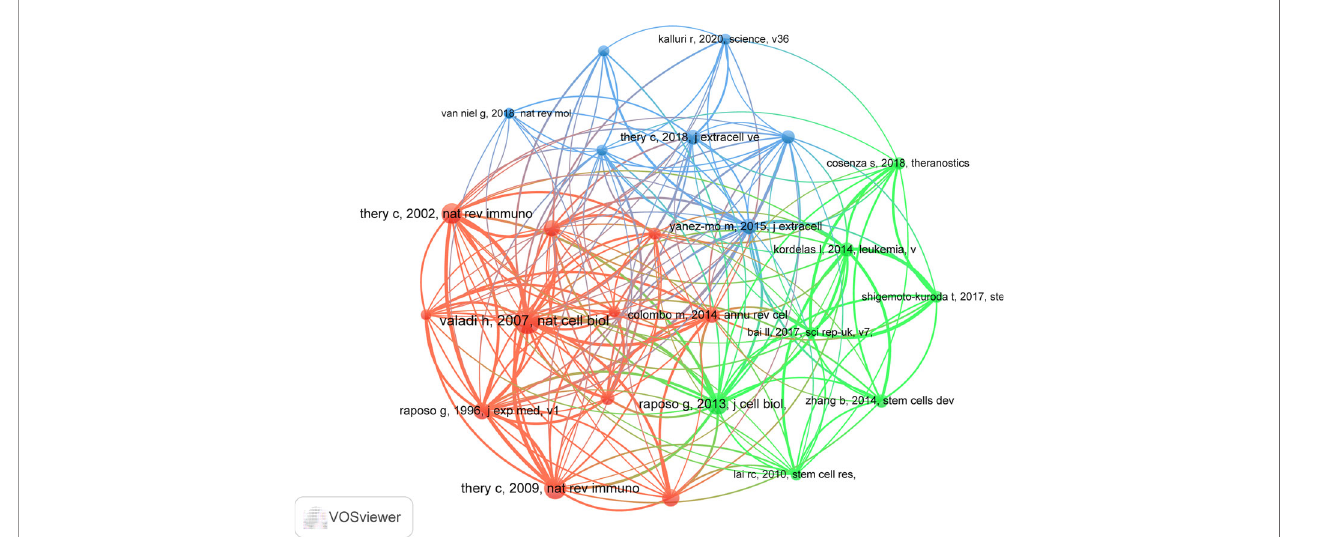
FIGURE 8 | The visualization of co-cited references on research of exosomes in